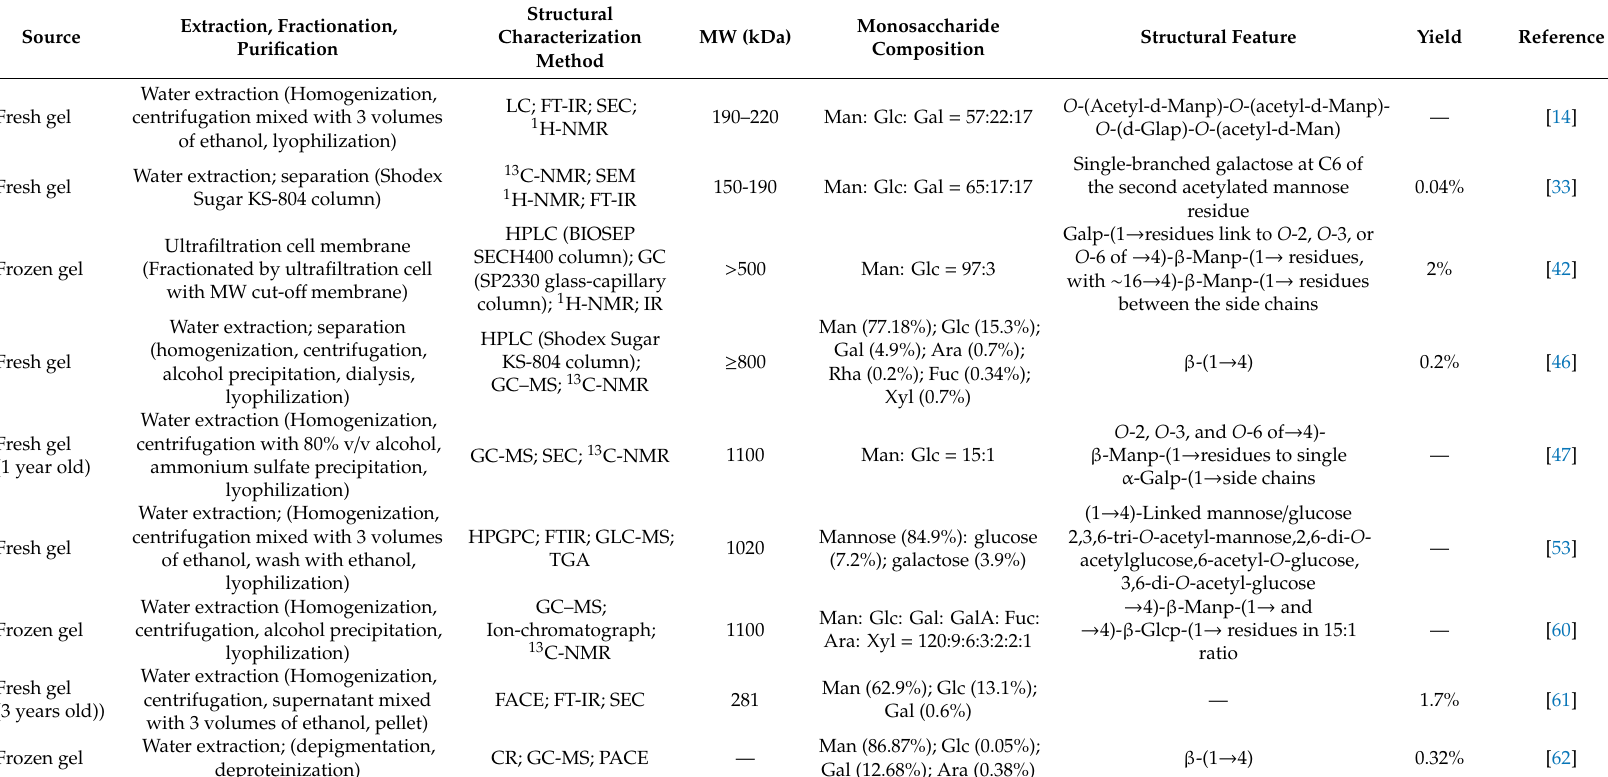
Table 1. Summary of the extraction, purification, characterization methods and structural studies of